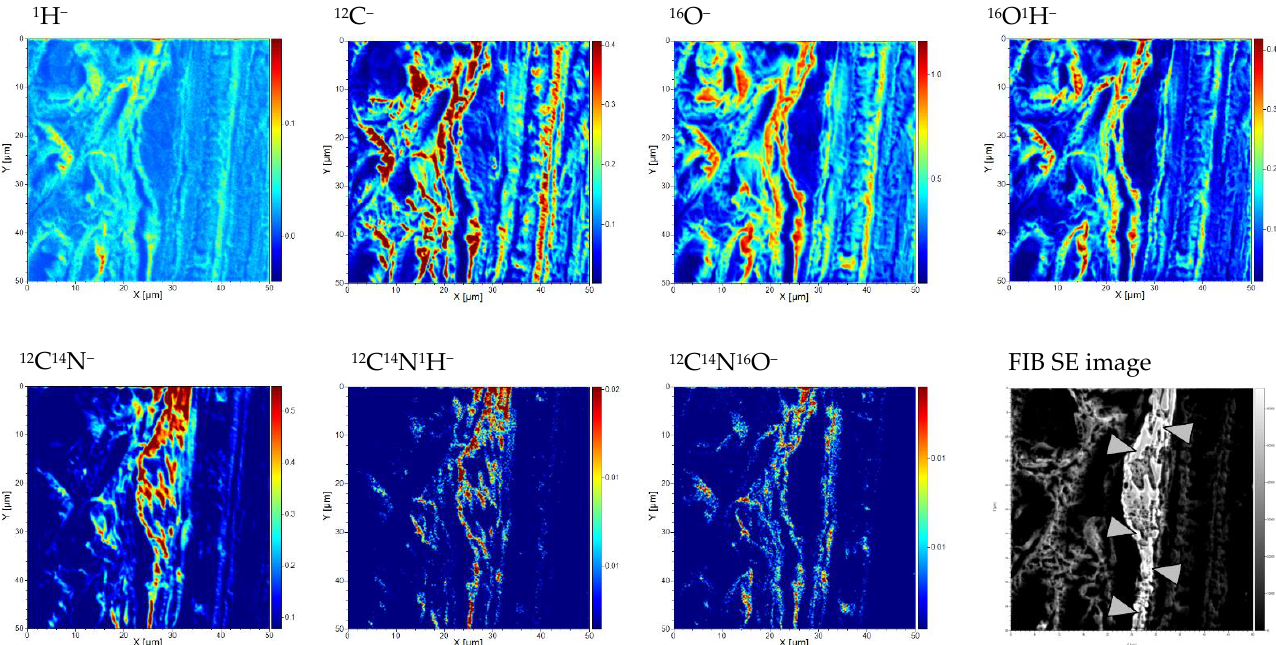
Figure 5. Elemental distribution maps of the selected isotopes and their molecular clusters for a cup-plant particle. The element exponent indicates a detected mass of ions or their clusters used for displaying of maps. Brighter regions in the FIB SE image refers to pMDI (marked); see Figure 2D for the selected area of interest SEM. Particle–particle bondlines for both PB types were visualized by TOF-SIMS. The Q/m 12 peak (carbon) was adopted to represent the genuine wood structure, while for